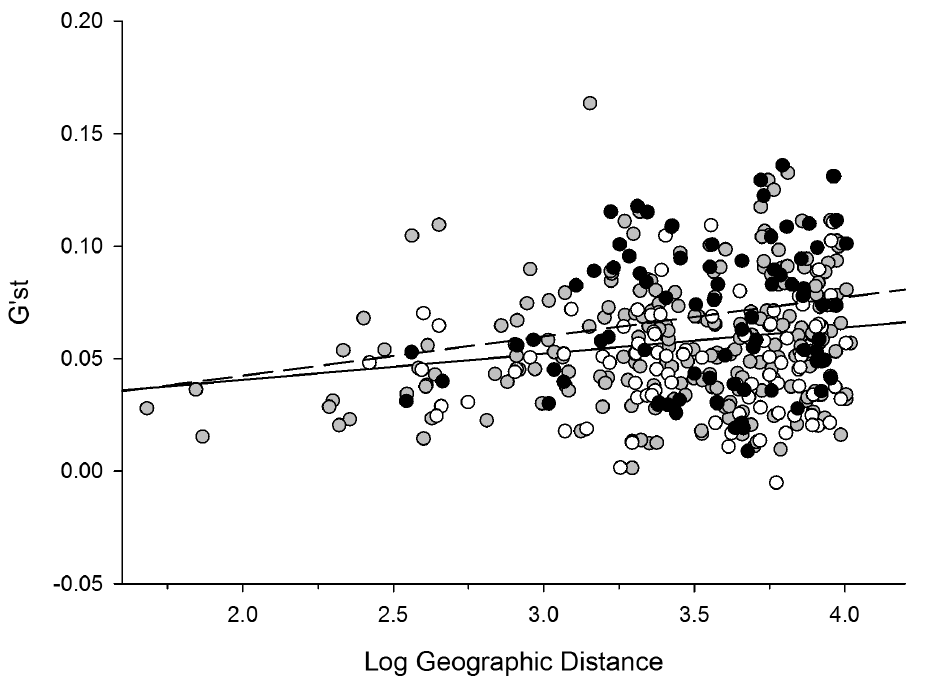
Figure 4. Isolation by distance graph. Correlation between Pairwise G’ ST values and logarithmic transformed geographic distance for all populations (all circles, continuous line (R M =0.17; b =0.012; P =0.001)), old populations (black circle, dashed line (R M =0.19; b =0.018; P =0.043)) and recent populations (open circle, no regression line (R M =0.069; b =0.0044; P =0.25)). doi:10.1371/journal.pone.0067255.g004 PLOS ONE |